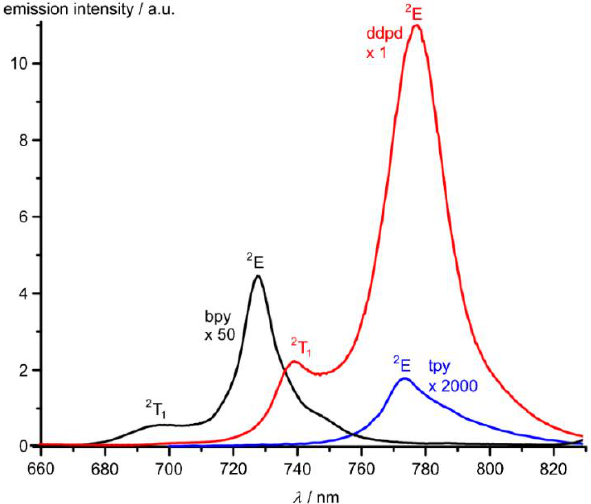
Figure 10. Luminescence spectra of [Cr(bpy) 3 ][PF 6 ] 3 (black) [Cr(tpy) 2 ][PF 6 ] 3 (blue) and [Cr(ddpd) 2 ][BF 4 ] 3 (red) in CH 3 CN. The bands are labelled with the respective term symbols. Please note the very different scaling factors.